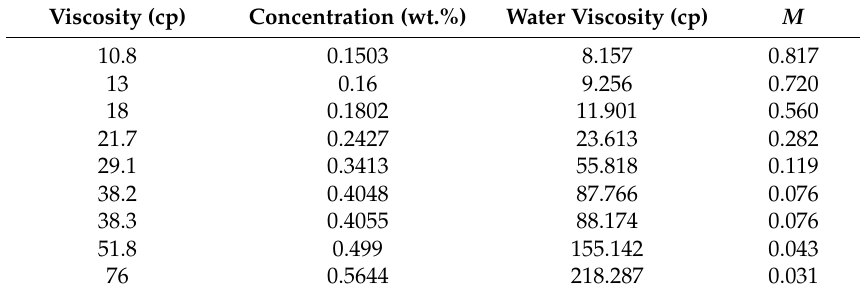
Table 3. Mobility ratio determination based on water viscosity as a function of polymer concentration.